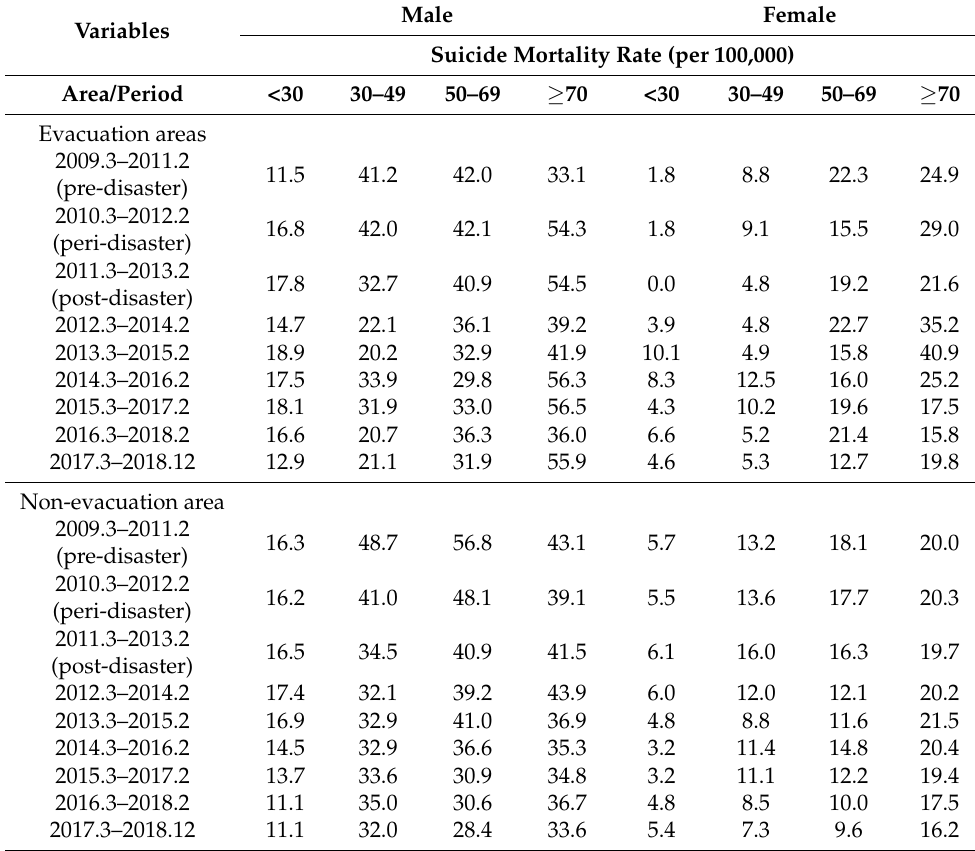
Table 2. Suicide mortality rate by age group in both evacuation and non-evacuation areas.